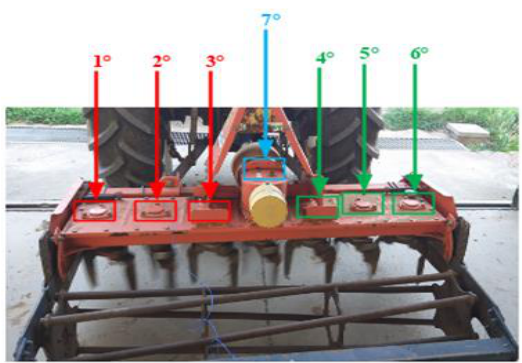
Figure 2. Rotary harrow under investigation.